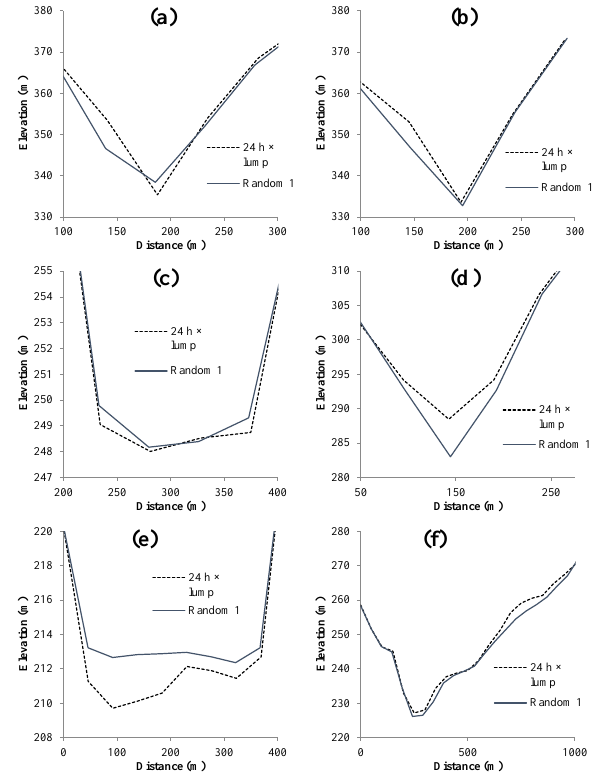
Figure 3. Cross sections identified in Figure 2.